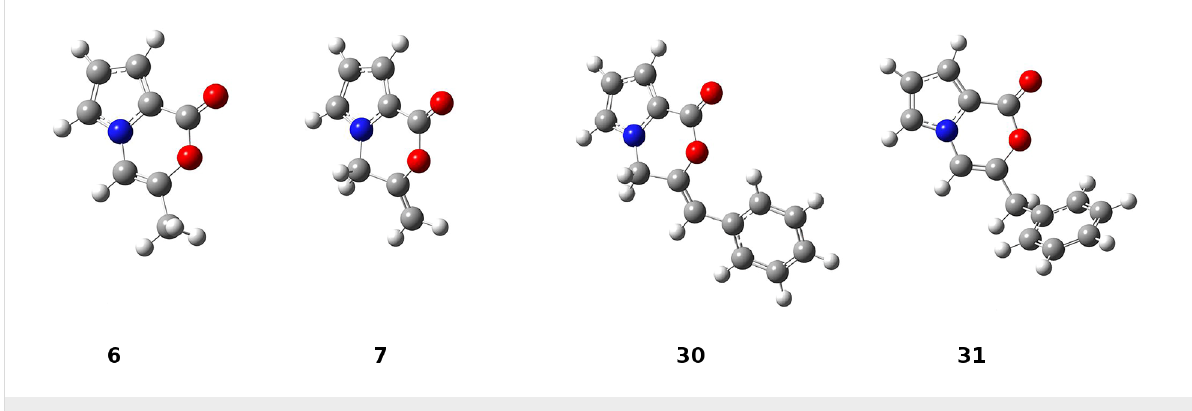
Figure 3: Geometry optimized structures of 6 , 7 , 30 and 31 .